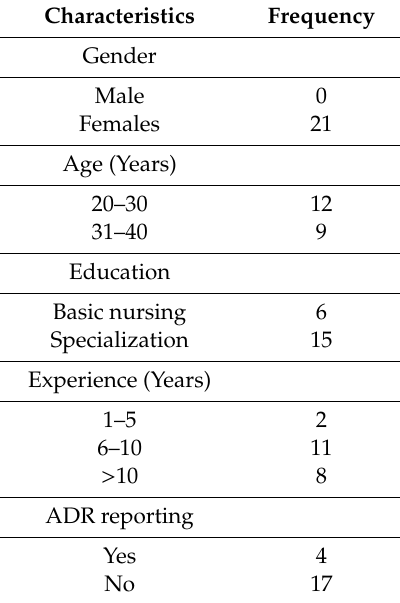
Table 2. Demographics of the participants.